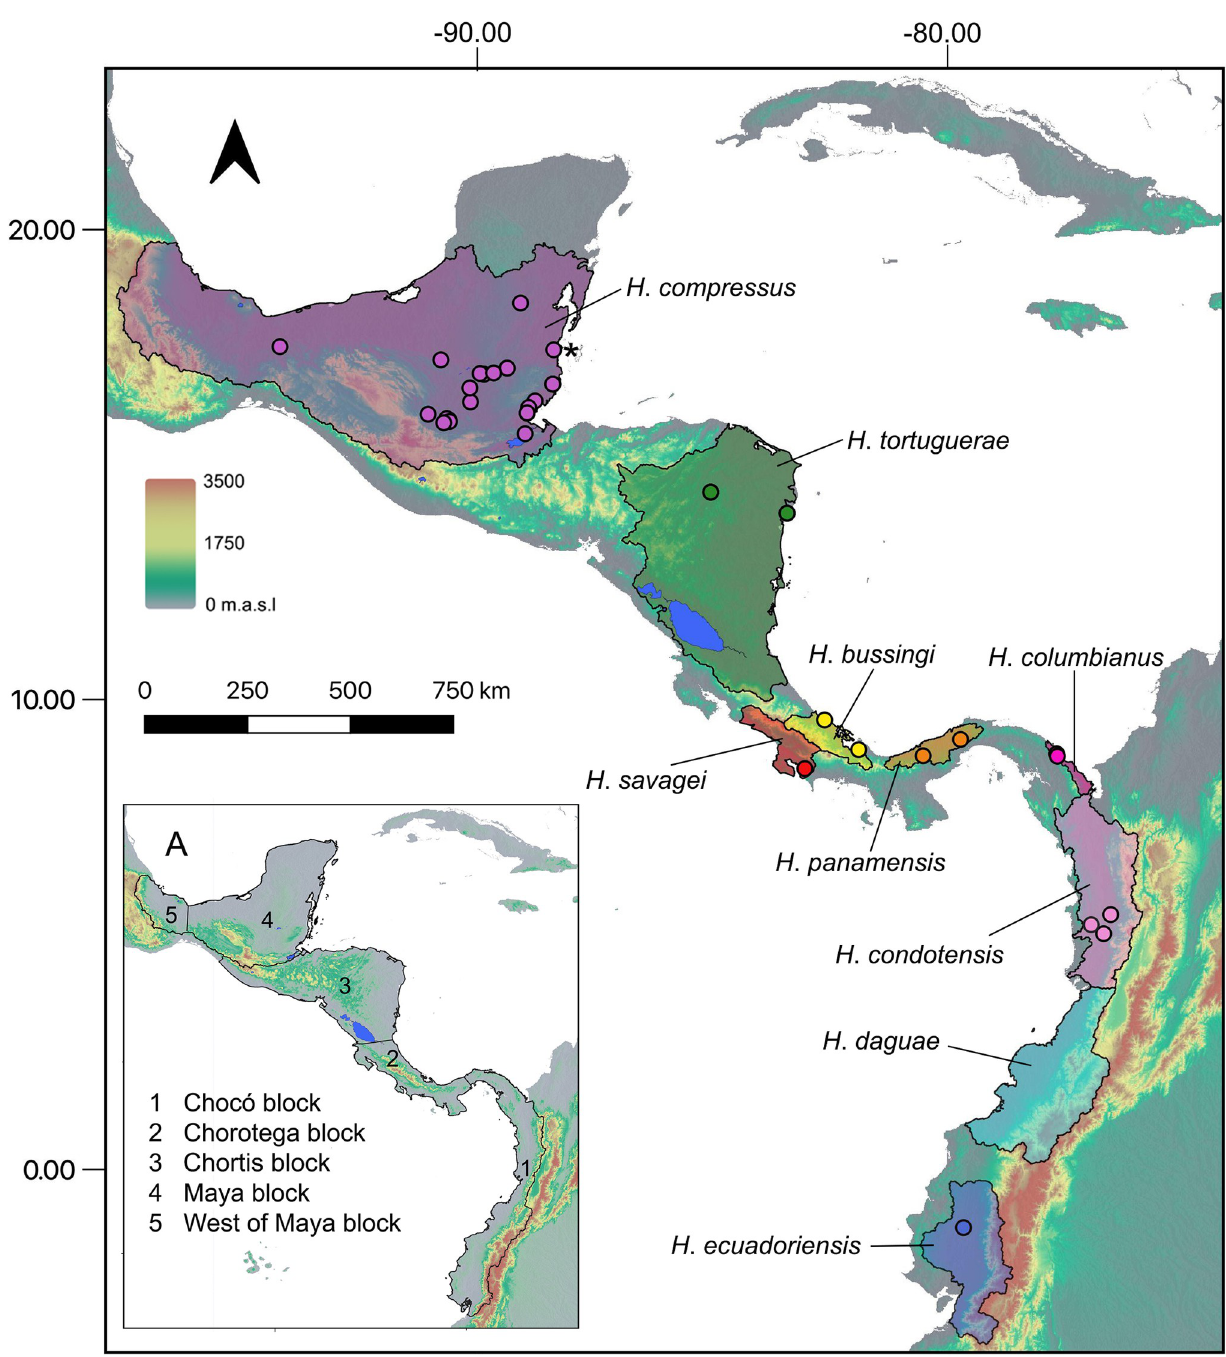
Fig 1. Map of Middle America showing the distribution of the nine valid species of trans -Andean Hyphessobrycon (shaded regions) based on river basin boundaries (see Materials and methods). Colored circles indicate the geographic locations of the samples analyzed in this study. The asterisk indicates the estimated locality of the sample of H . compressus from Melo et al. [9] A) Geological blocks in Middle America used as biogeographic units. Km = kilometers, m.a.s.l = meters above sea